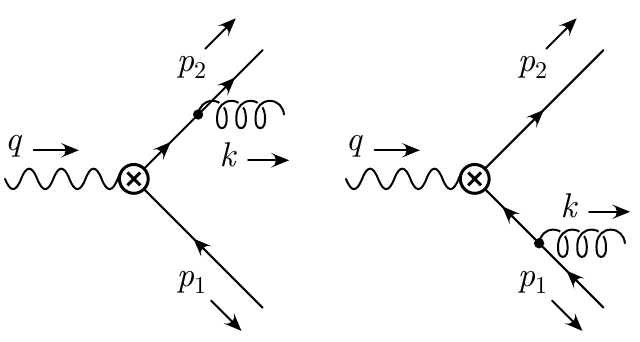
Figure 1 . QCD graphs contributing to three-body (cid:12)nal